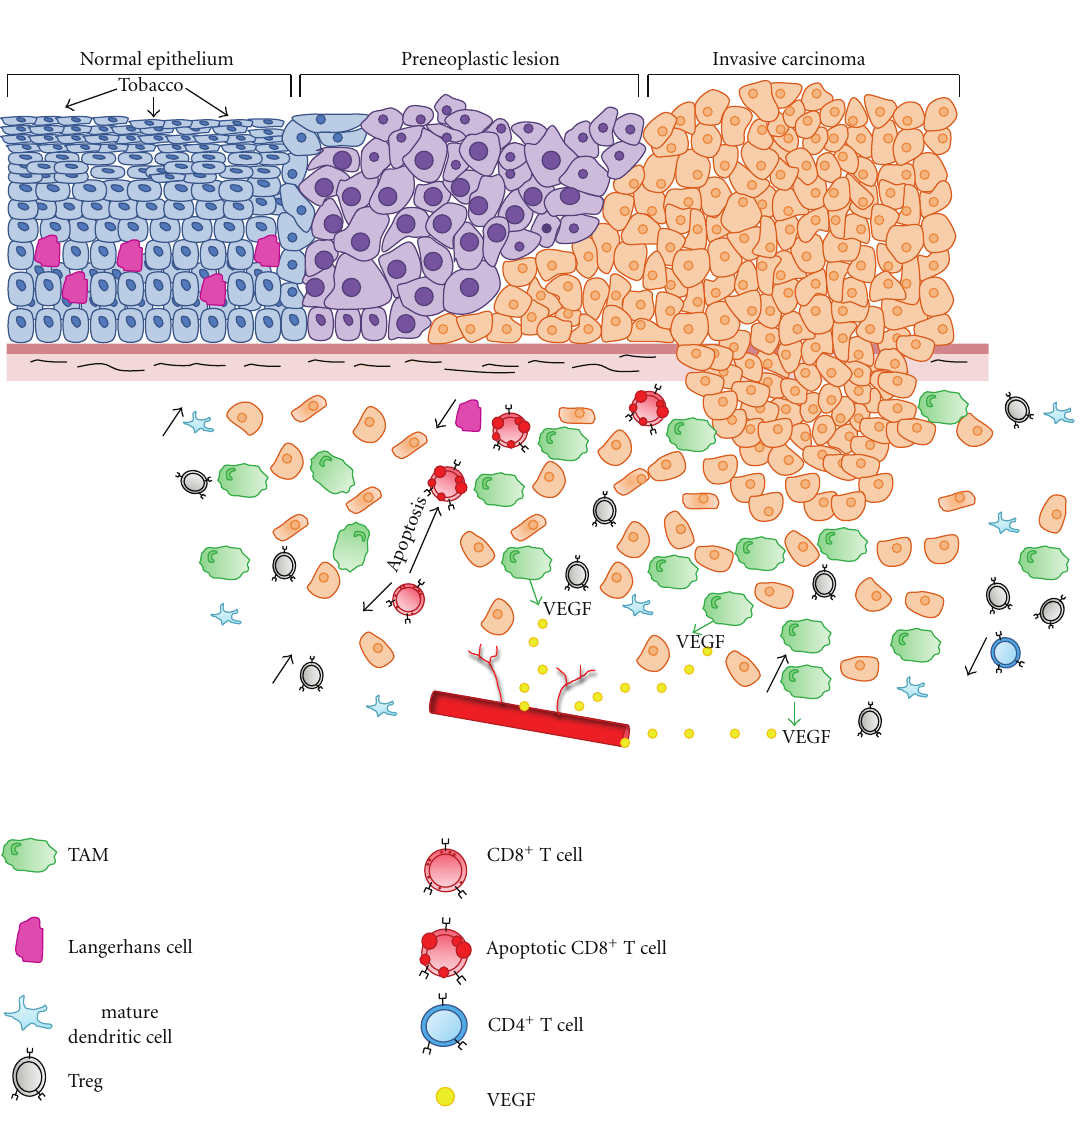
Figure 2: Description of immunosuppressive mechanisms during the head and neck tumor progression: in the normal epithelia of the upper aerodigestive tracts, LCs are present in the suprabasal layers. When mucosae of these areas are exposed to tobacco, the number of LCs increases whereas these cells decrease in invasive carcinomas. The mature DCs are prominent in the peritumoral area and correlated positively with the expression of VEGF. DCs are also more abundant in patients with metastasis. A higher level of TAM is observed in HNSCCs, and these cells constitute a source of VEGF which play a crucial role in angiogenesis. HNSCCs can induce the apoptosis of CD8 + T cells using the mitochondrial and/or Fas/FasL pathways. Tregs can induce apoptosis of CD8 + T cells and inhibition of the proliferation of CD4 + T